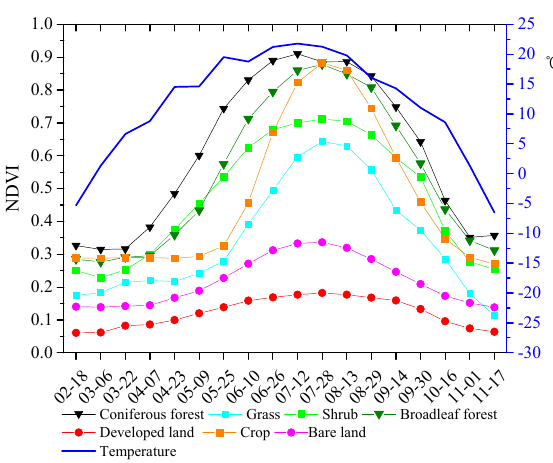
Figure 6. Representative NDVI profiles of the seven main land cover types and the dynamic of temperature. X-axis refer to the dates of the synthetic images. Daily mean temperature for Fengning station (41°7 ′ 48 ″ N, 116°22 ′ 48 ″ E) were obtained from the China Meteorological Data Sharing and Service System (http://data.cma.cn/) and the mean values for every 16 days were calculated.